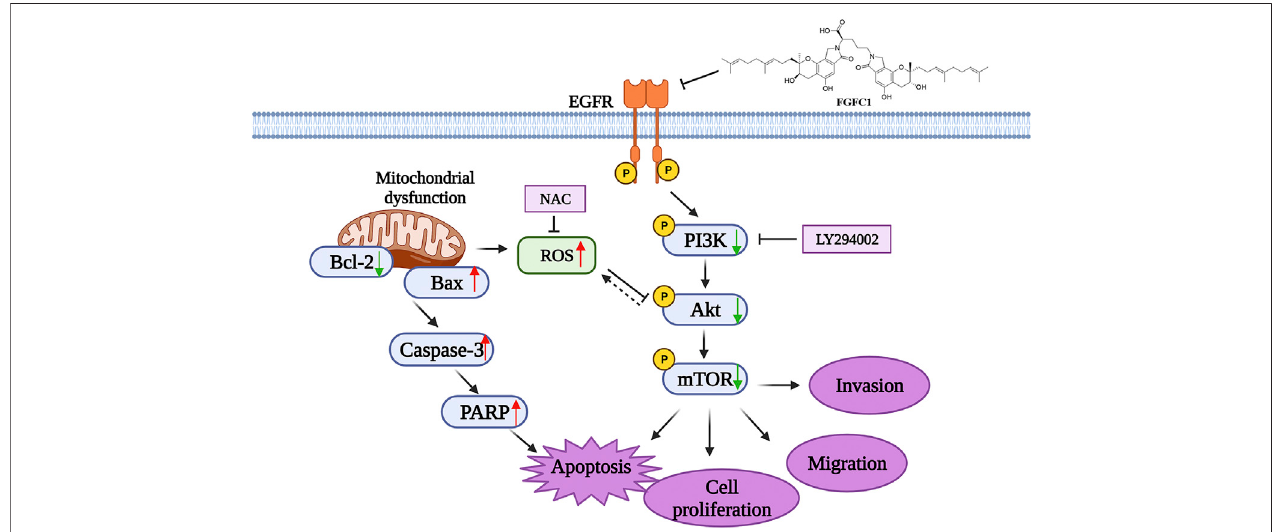
FIGURE 7 | The proposed mechanism of the effect of FGFC1 on NSCLC